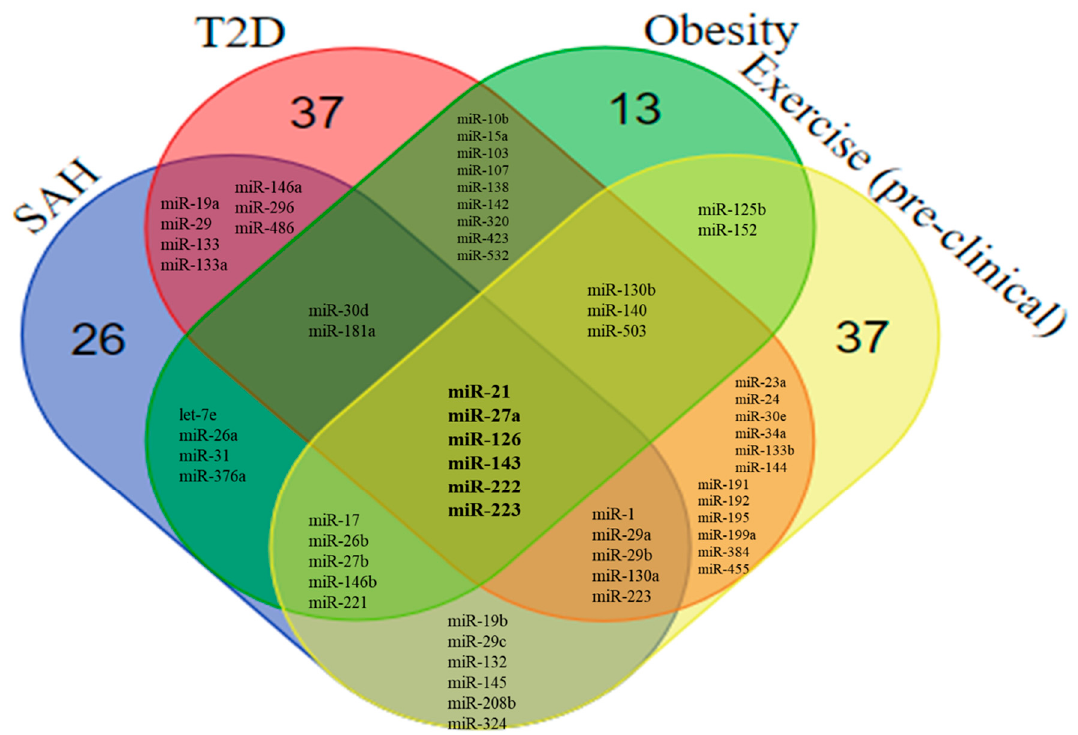
Figure 4. A Venn diagram of hypertension, diabetes, obesity, and their overlapping with exercises (pre-clinical). The Venn diagram was used to identify overlapping and non-overlapping miRNAs in the analysis of studies on the microRNA profile of expression in cardiometabolic diseases and pre-clinical studies on exercise training.